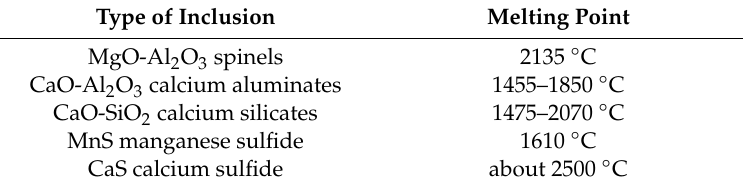
Table 3. Melting points of inclusions occurring in electrode charges and ESR / PESR ingots, data from